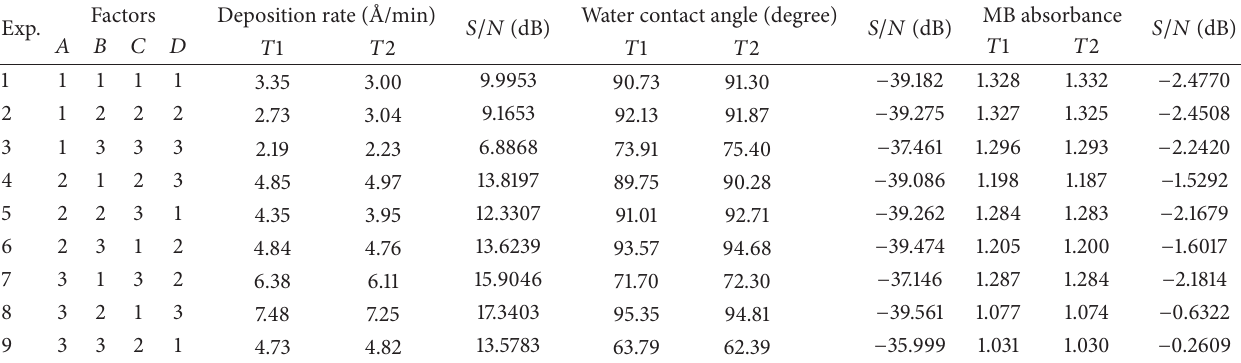
Table 2: The experimental results and the 𝑆/𝑁 ratios for the deposition rate, the contact angle, and the MB absorbance for the TiO 2 compact layer coatings (the experiments were repeated twice).